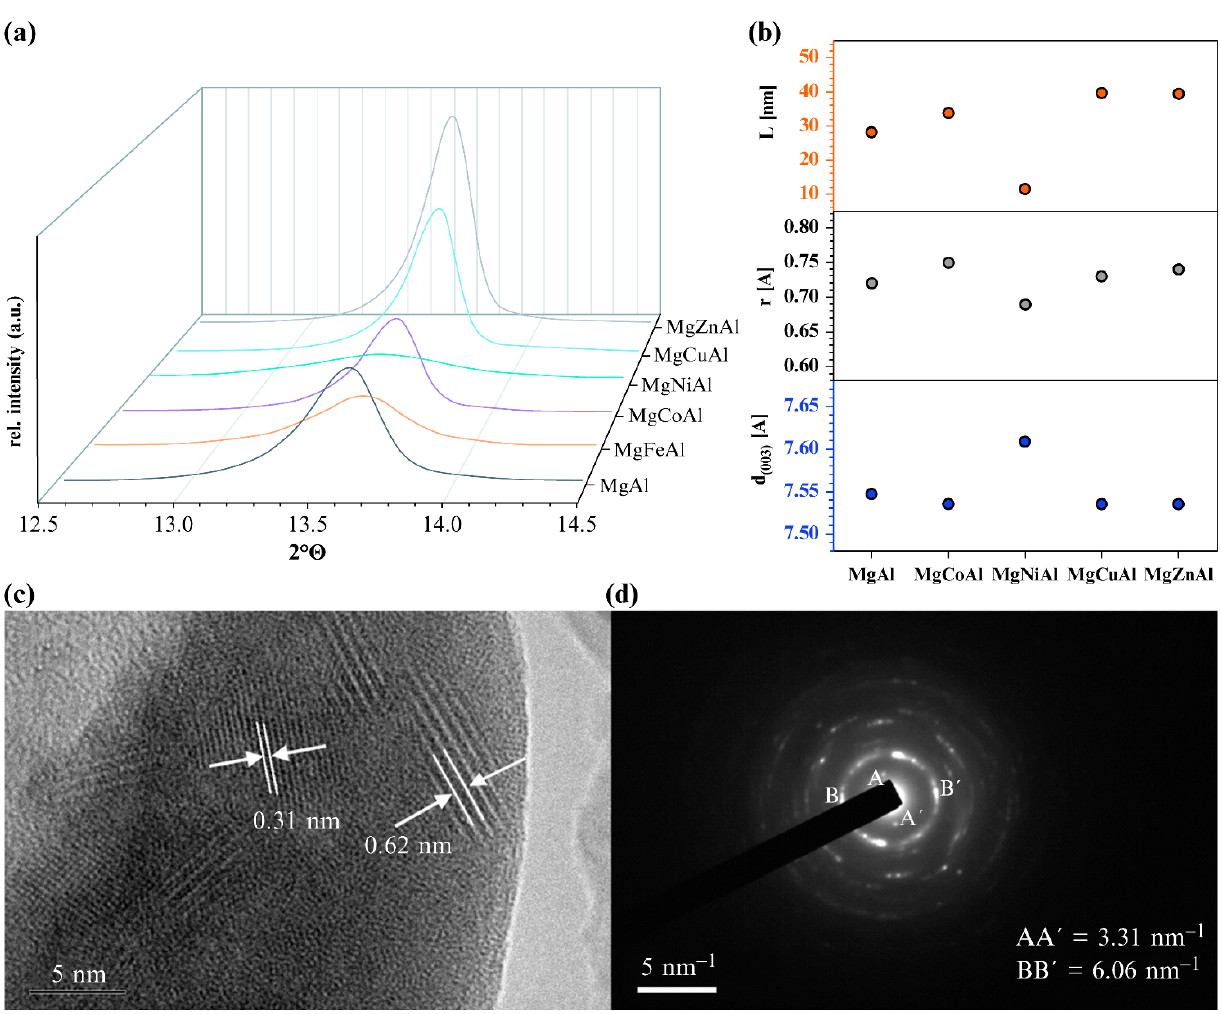
Figure 8. ( a ) XRD pattern of (003) reflexes for various MgMAl LDHs. ( b ) Relationship between the atomic radius, d-spacing, and grain size of the MgAl − LDHs substituted with 5% divalent transition metals. Reproduced with permission from [59]. ( c ) High resolution transmission electron micros- copy (TEM) image of LaLiAl LDH. ( d ) Selected area electron diffraction pattern of LaLiAl LDH. Reproduced with permission from [60]. LDH. Reproduced with permission from